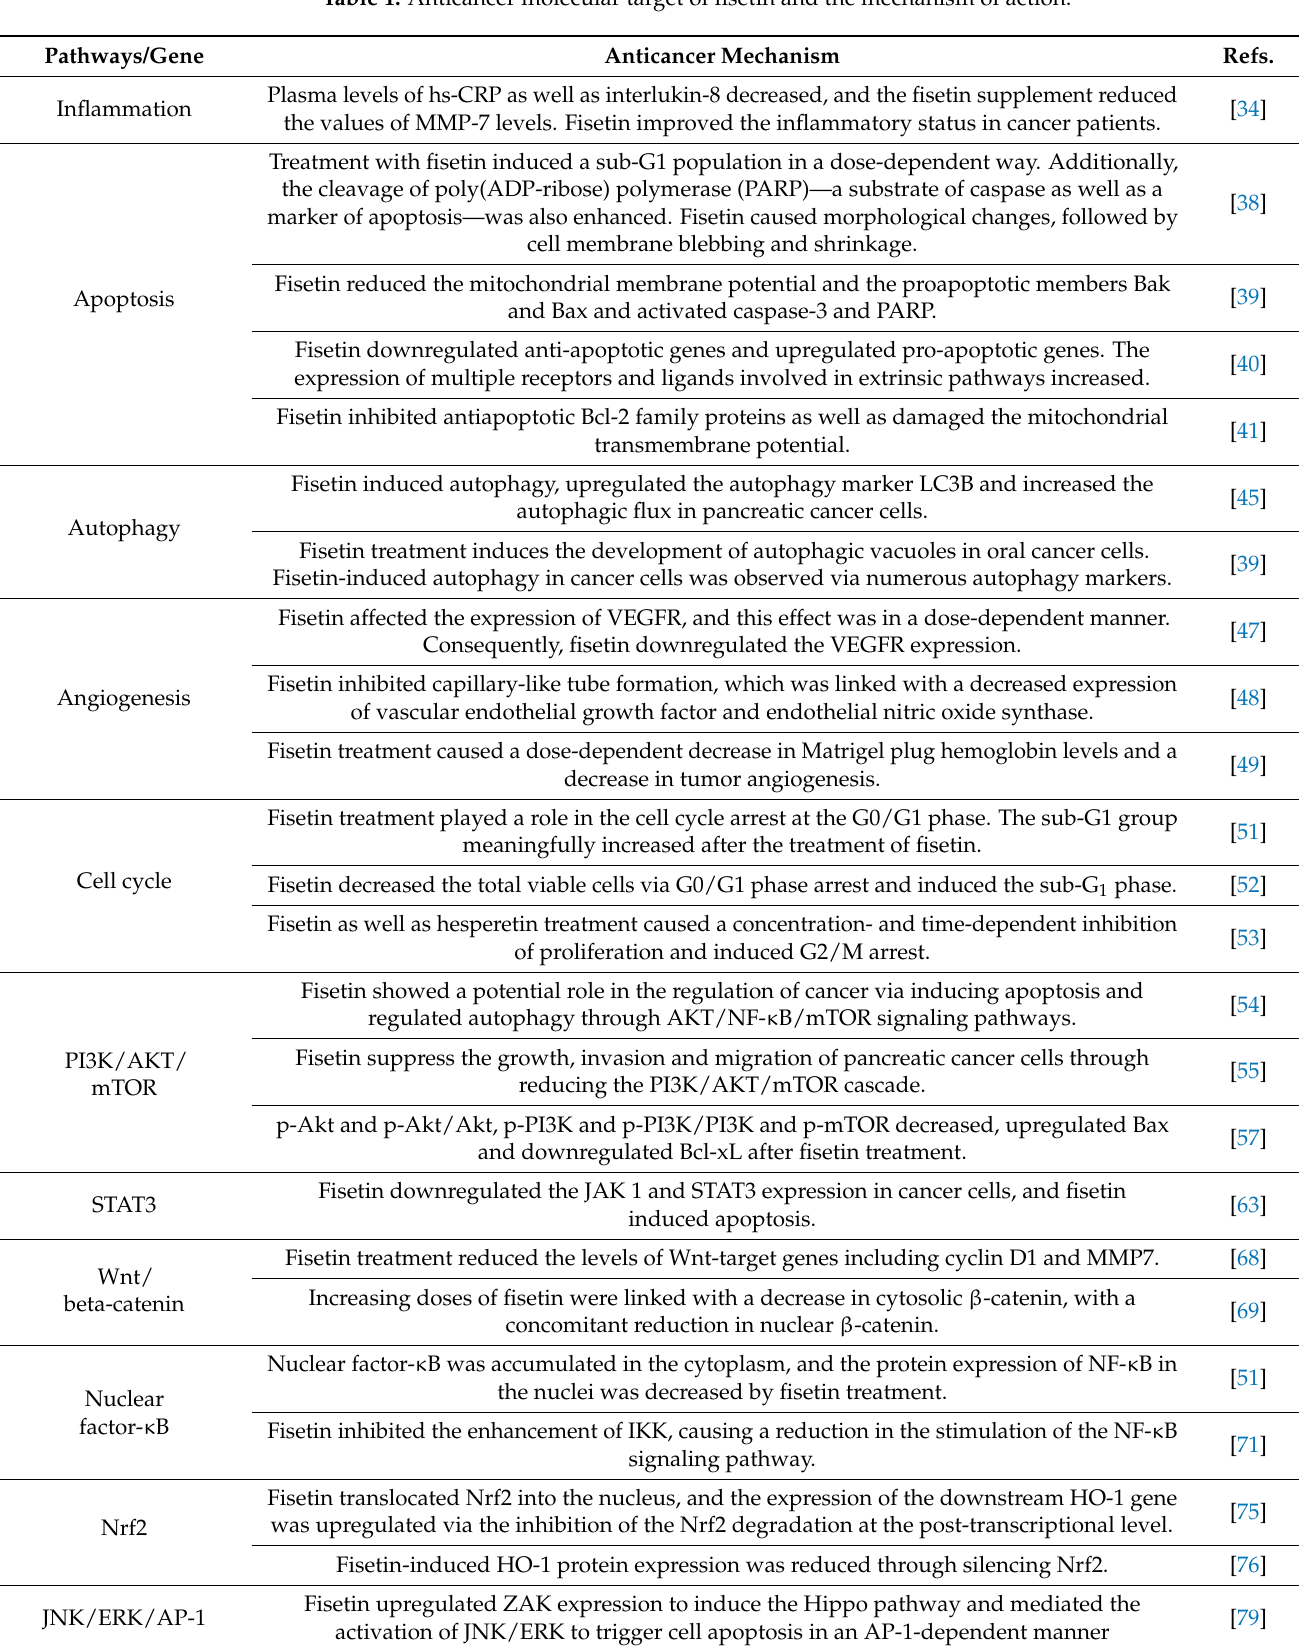
Table 1. Anticancer molecular target of fisetin and the mechanism of